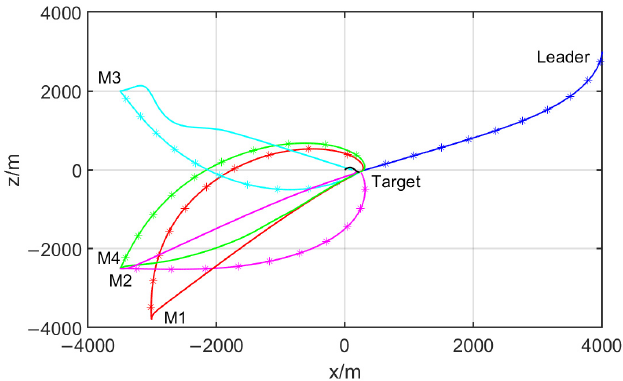
Figure 10. Projection of flight trajectory curve of cooperative attack on target 3 in the XOZ plane.